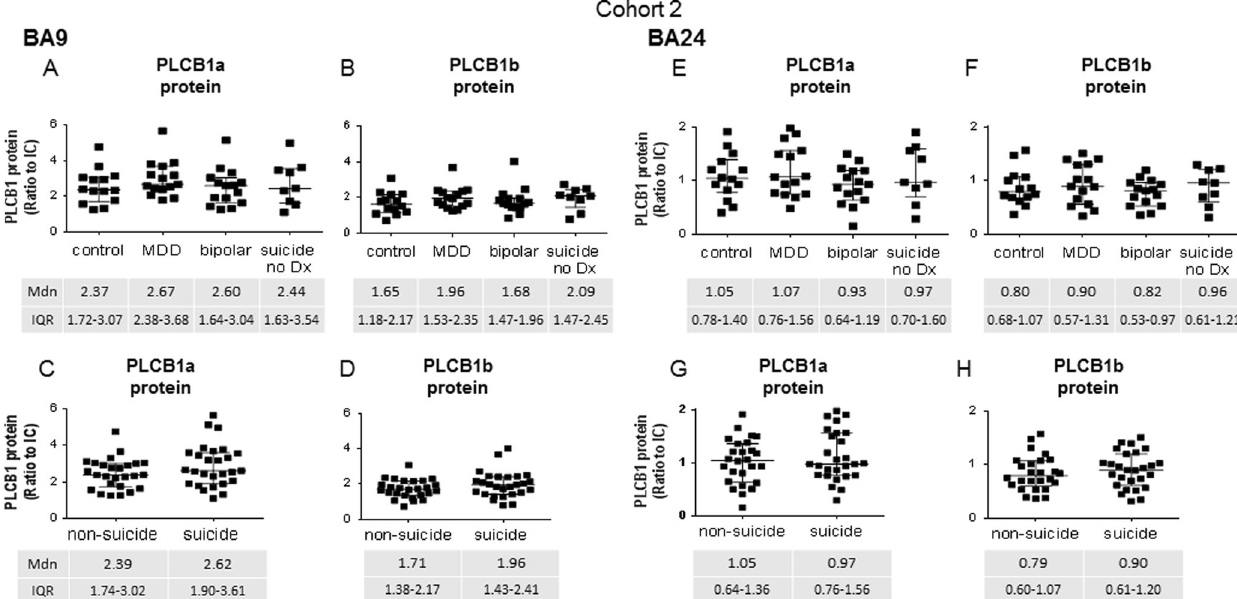
Fig. 3 PLCB1a and PLCB1b protein levels in cohort 2 measured in tissue from BA9 ( a – d ) and BA26 ( e – h ), analysed as subjects with MDD, BD, and subjects who died of suicide who had no history of psychiatric illness (suicide no Dx), compared to control ( a ), ( b ), ( e ), ( f ), and with all subjects in this cohort divided into suicide completers vs. non-suicide ( c ), ( d ), ( g ), ( h ). Error bars show median (Mdn) and